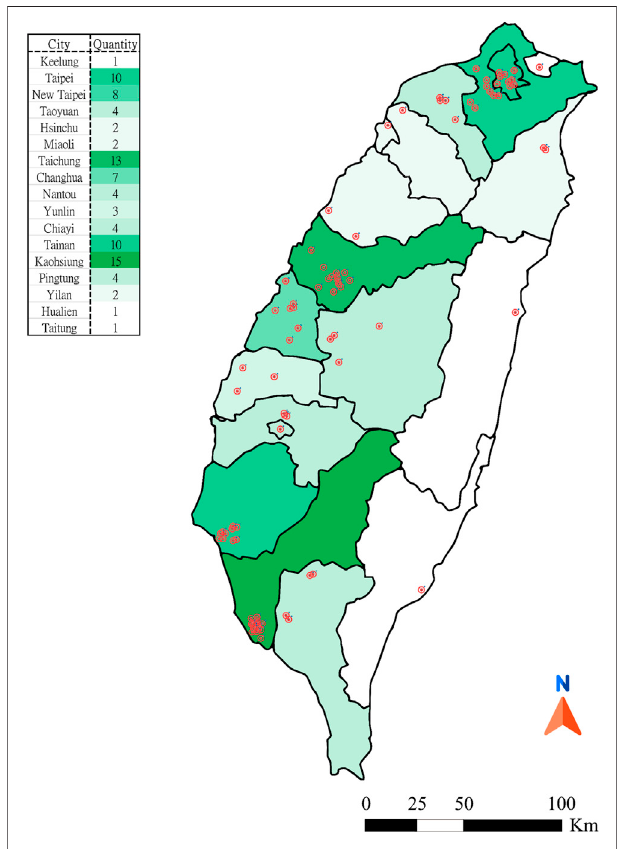
FIGURE 1 | Distribution map of 91 hypolipidemic